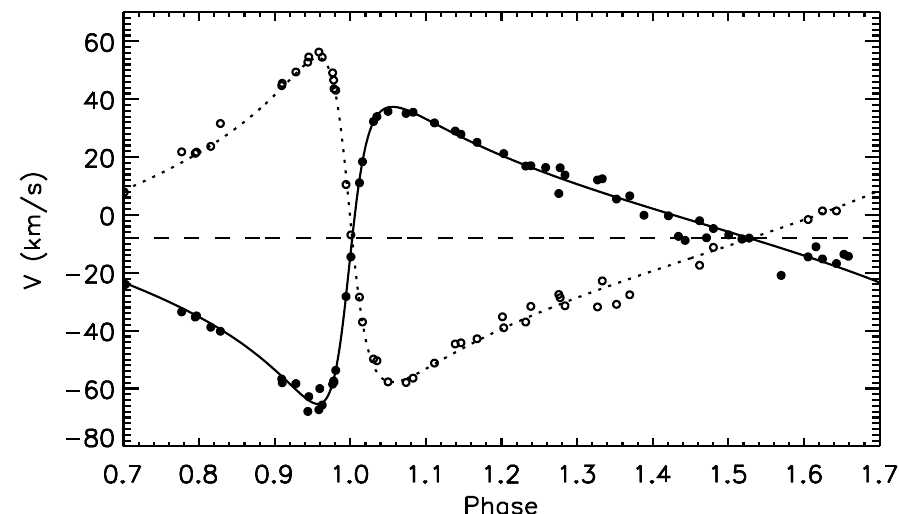
Fig. 3. The result of analysis of radial velocities from Griffin